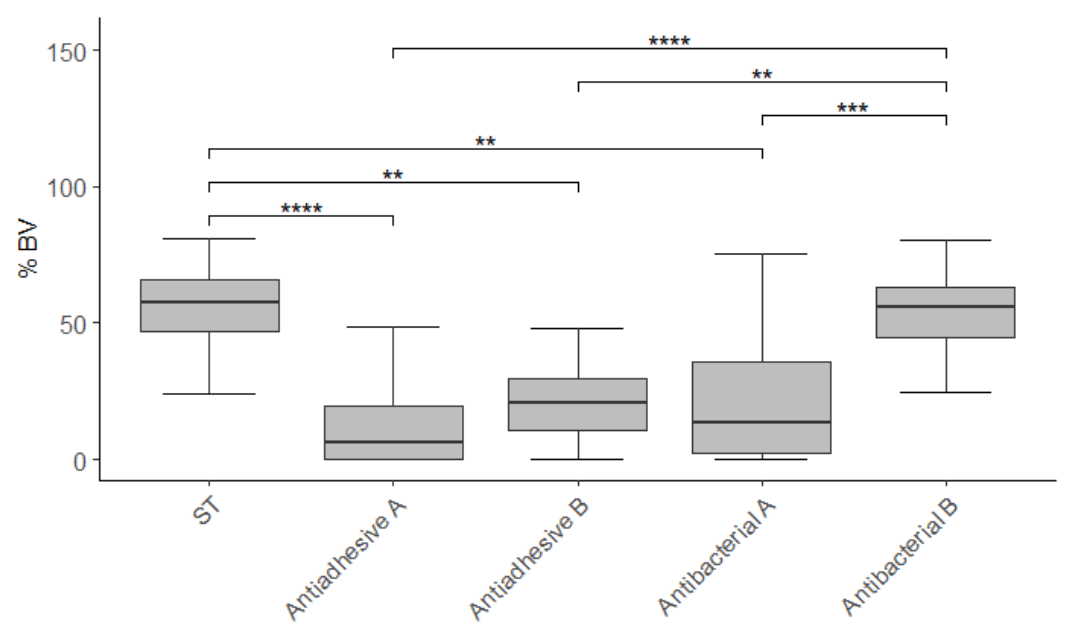
Figure 3. Tukey box plots of BV without outliers. Significant differences are bracketed with asterisks (*, p < 0.05; **, p < 0.01; ***, p < 0.001; ****, p < 0.0001).